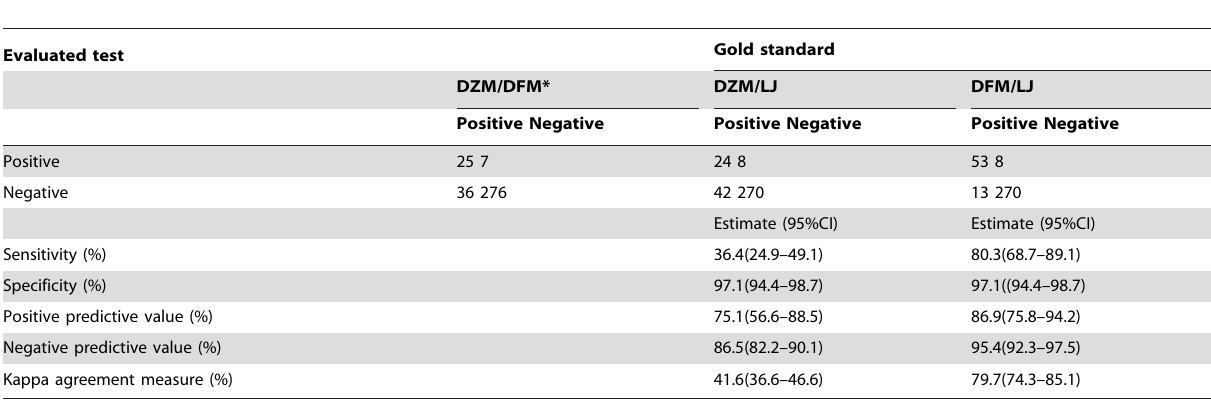
Negative predictive value